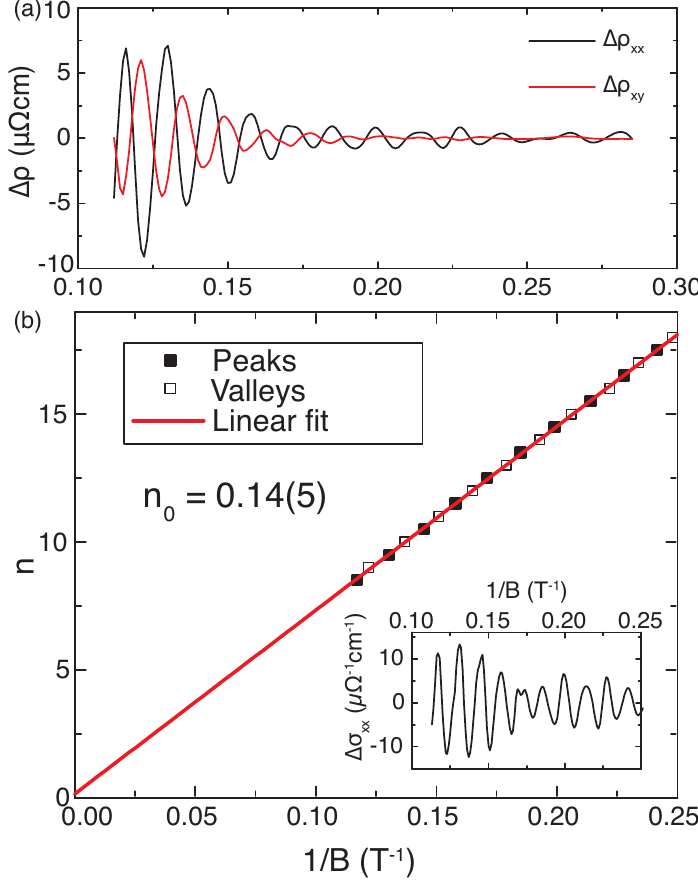
Figure 7: Landau level diagramme for the analysis of the Berry phase in SrMnSb ρ and ρ vs. 1 / B after background subtraction; (b) Landau level index diagram for xx x y the SdH oscillations in the conductivity, plotted by assigning integer values to the valleys of σ = ρ / ( ρ 2 + ρ 2 ) − shown in the inset. The linear fit gives n xx xx xx x y a trivial Berry